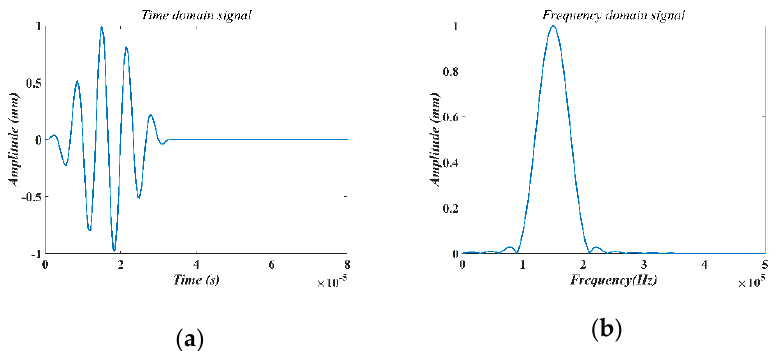
Figure 2. The incident wave. ( a ) Time-domain signal. ( b ) Frequency-domain signal. Table 2. The parameters of the incident waves.